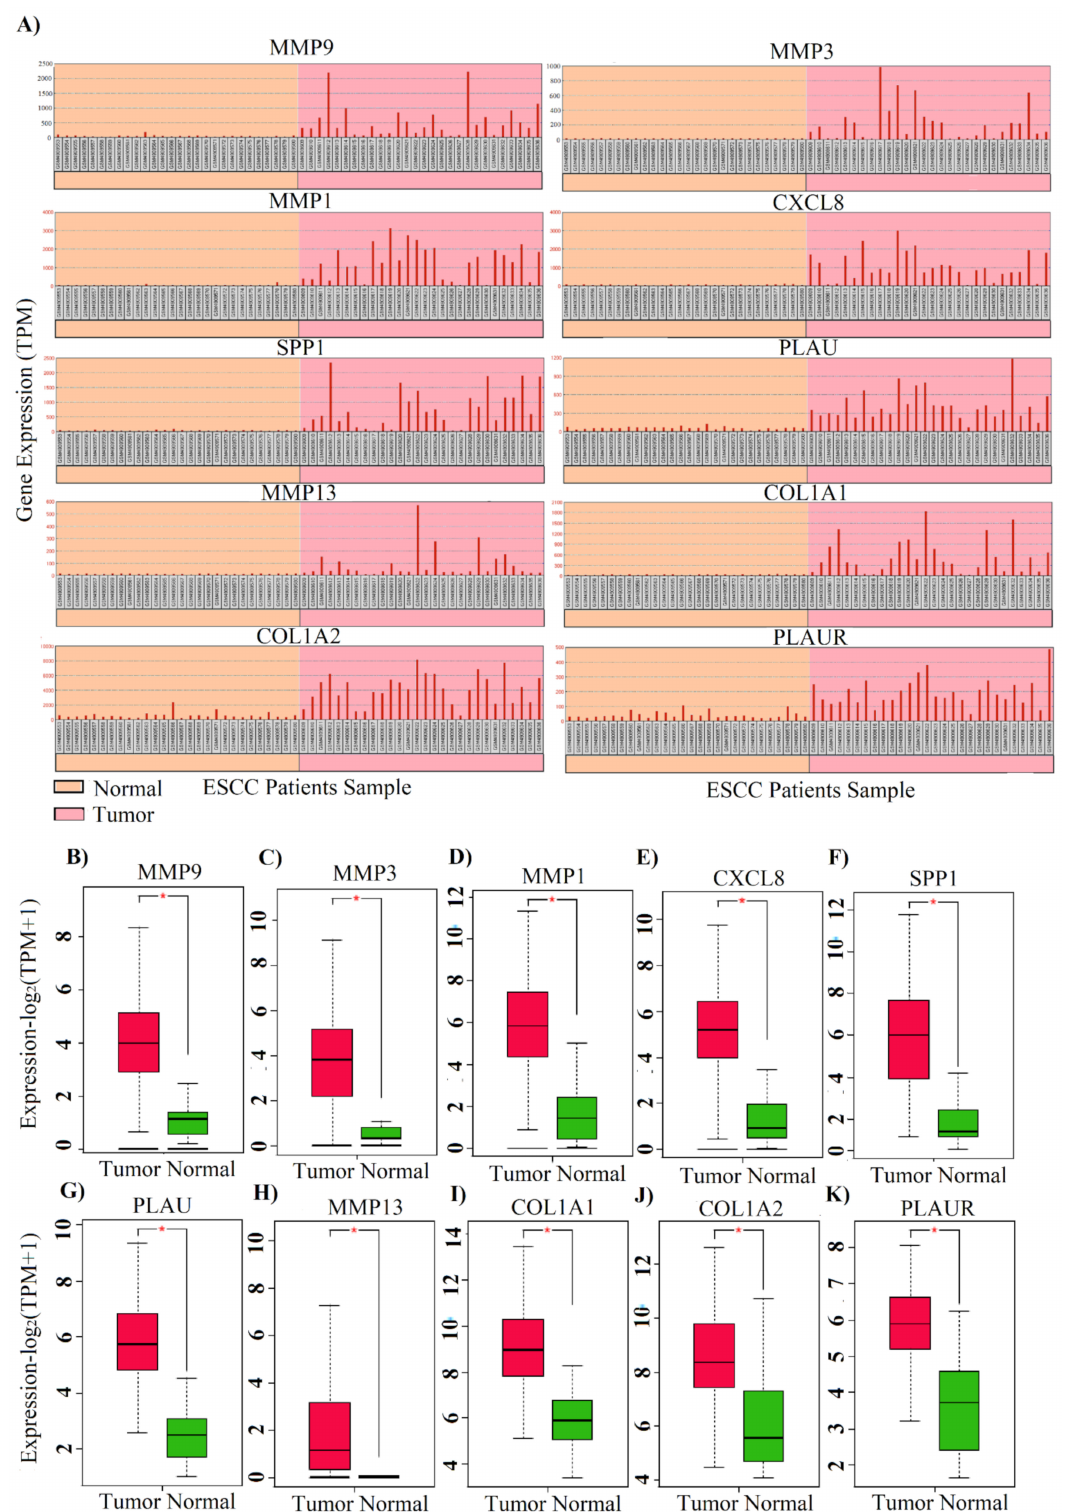
Figure 3. The gene expression analysis for the predicted HGsT10 genes. ( A ) The HGsT10 gene expression at ESCC tumor condition was compared with normal samples showed the upregulation. ( B – K ) The HGsT10 genes expression were validated with TCGA samples with the log-transformed expression value, which includes 13 normal and 182 tumor samples. * denotes statistical significance ( p <